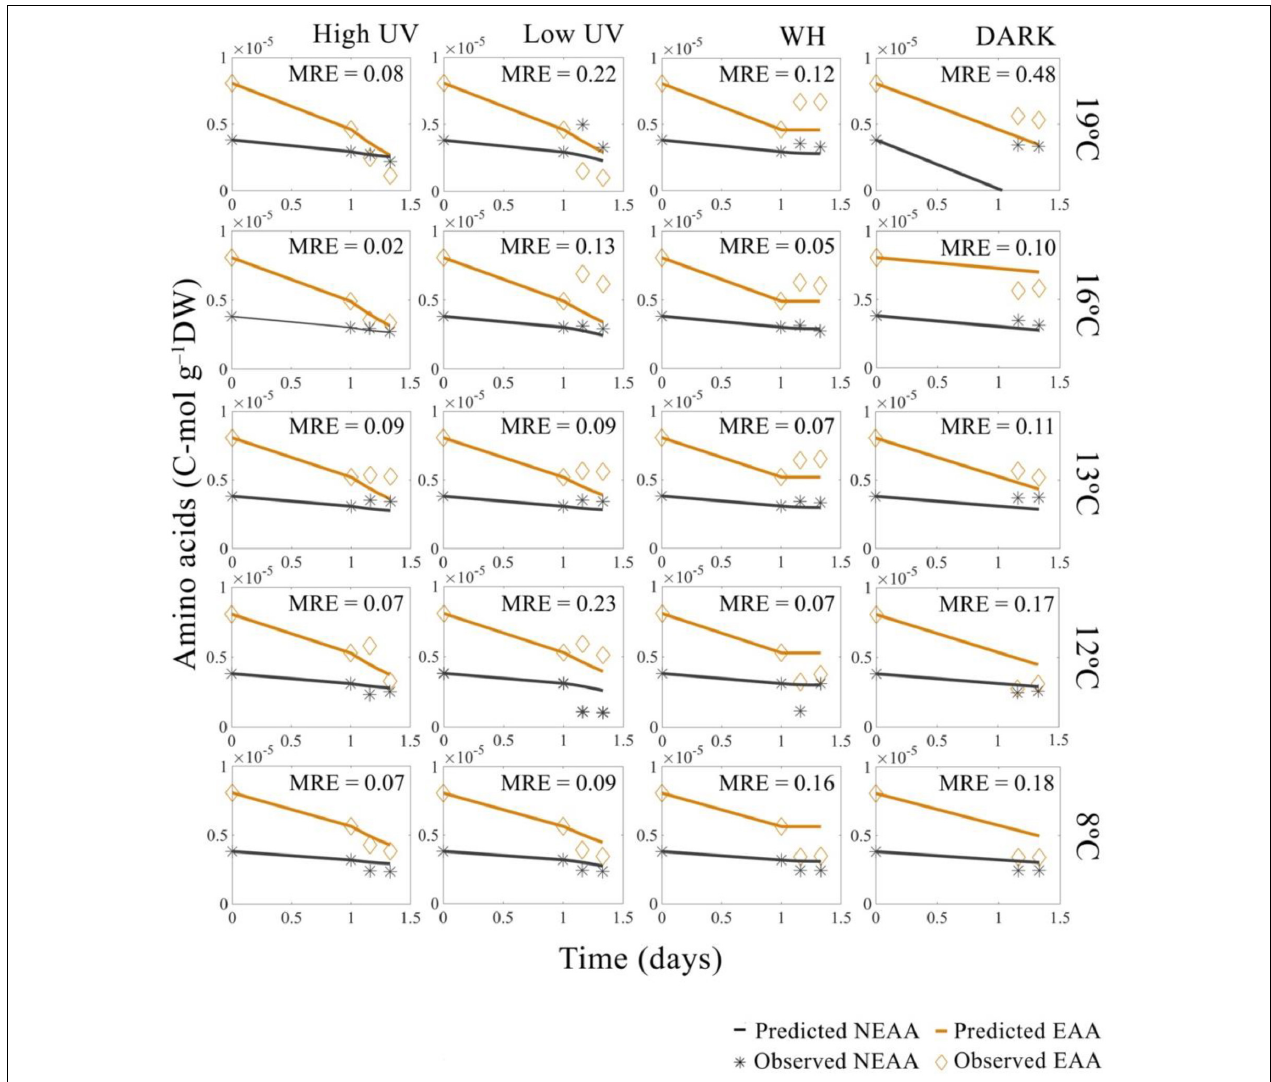
FIGURE 5 | Predicted and observed decrease in Nyctiphanes australis amino acid concentrations in time for all temperatures and light treatments: high UV, low UV, PAR, and DARK. MRE represent the mean relative error across amino acids type (EAA and NEAA) for each DEB model prediction. All observed values used for DEB prediction are the total sum of amino acids converted into C-moles. For model predictions of UV and PAR treatments the value of amino acids at 1 day (24 h) of starvation was interpolated from the negative control data, which represent krill not exposed to